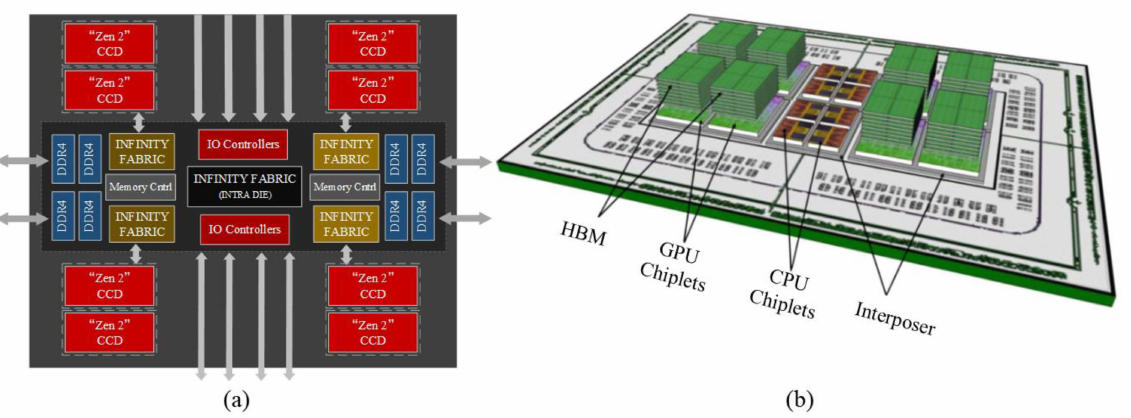
Figure 2. ( a ) “Rome” CPU architecture (reprinted from Ref. [26], Copyright 2021, with permission from IEEE); ( b ) Chiplet-based accelerated processing units (reprinted from Ref. [28], Copyright 2017, with permission from